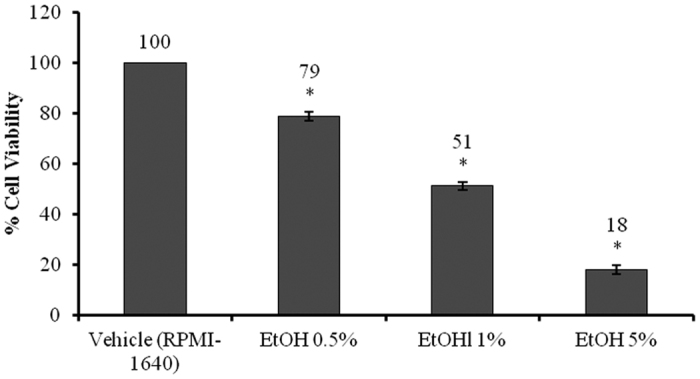
IC50 of ethanol (EtOH).Data are reported as Mean ± SEM (n = 3). Asterisks (*) indicate significant (P < 0.05) differences relative to the vehicle (RPMI-1640).